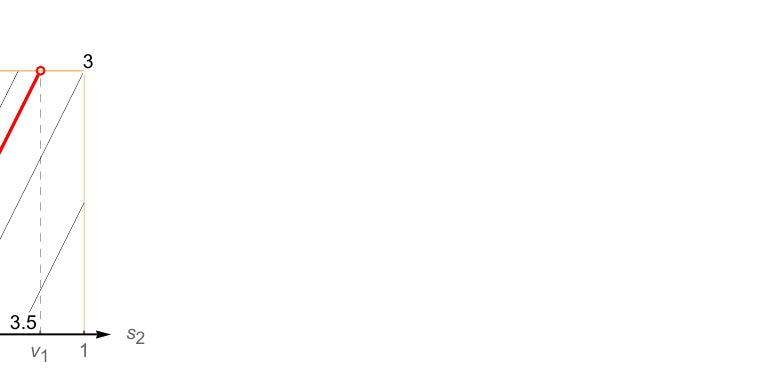
Figure 4. Thin lines correspond to curves-of-equal-payoff for player 1. As before, the red line corresponds to the attainable set S I ( v ) of player 1 for v = ( 5 of payoffs equal to 8/3. Strategies u = v = ( 5